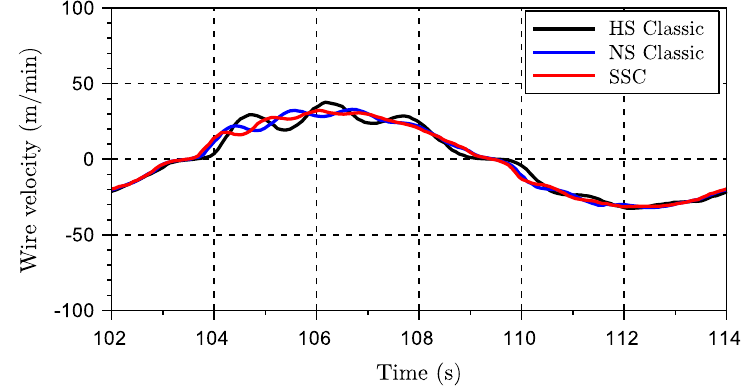
Figure 15. Wire velocities for scenario